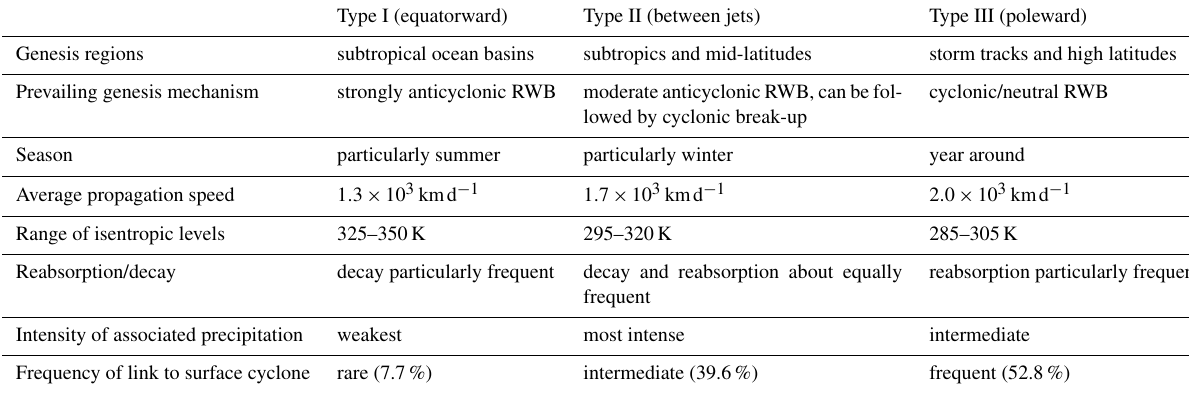
Table 1. Characteristics of the three PV cutoff